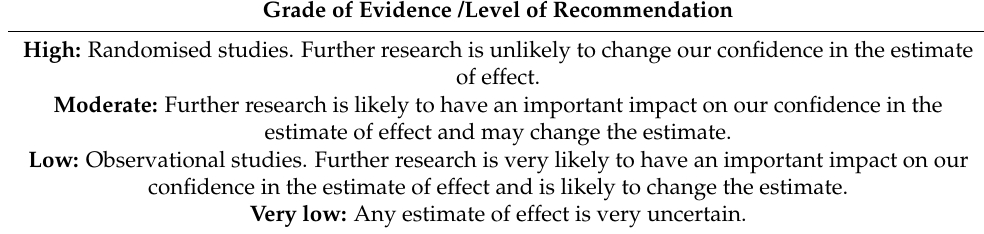
Table 3. Criteria for quality assessment under GRADE based on study design [32]. Grade of Evidence /Level of Recommendation